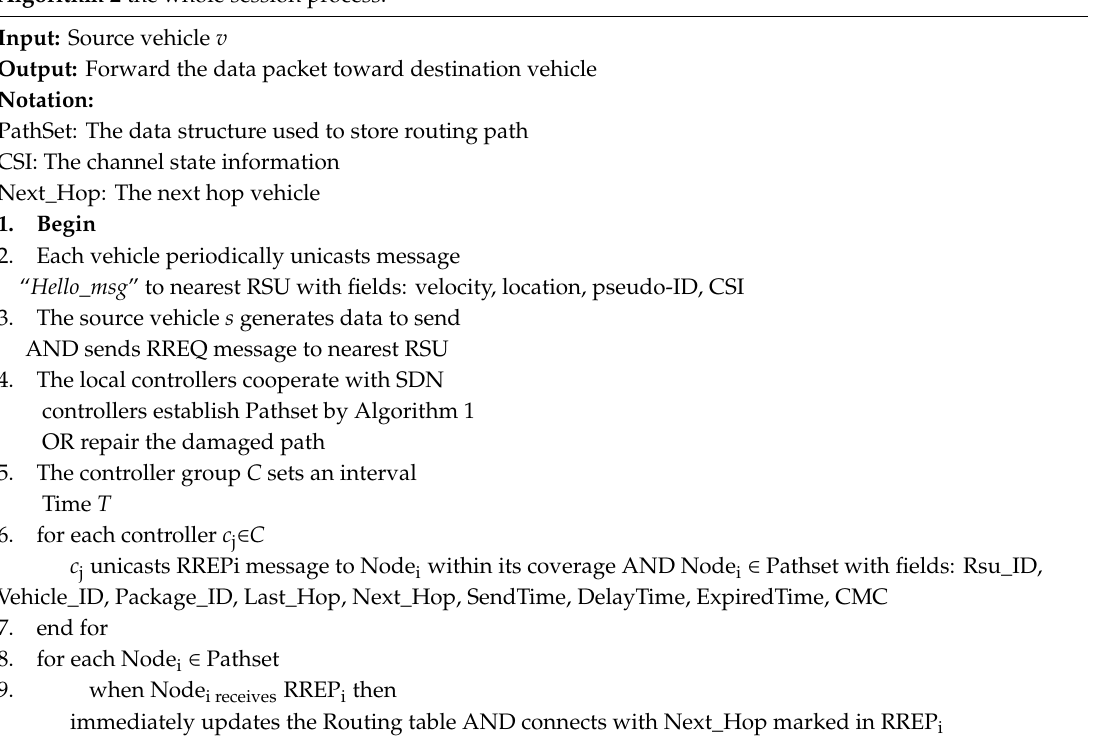
Algorithm 2 the whole session process.